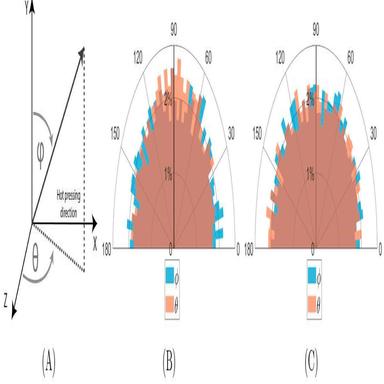
A) Spherical coordinate convention for orientation. B) AD85 nearest neighbor orientation polar histogram. C) AD85 pore major axis orientation polar histogram. The blue and orange represent the ϕ and θ distributions, respectively. The black line at 90° represents the long dimension of the sample. (For interpretation of the references to color in this figure legend, the reader is referred to the Web version of this article.)